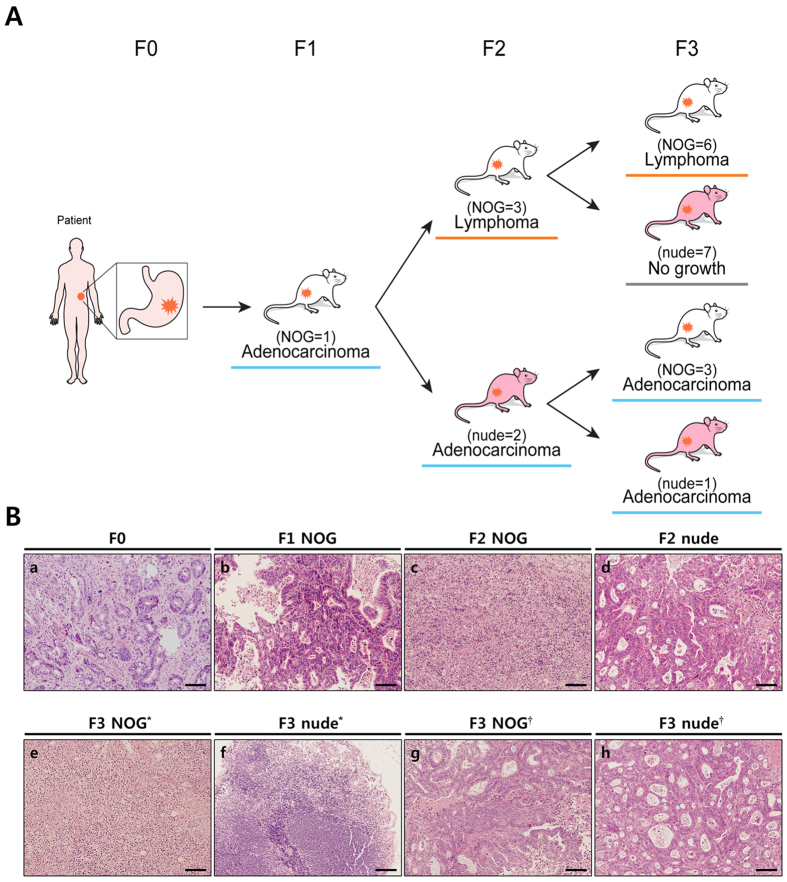
Schematic drawing of sequential histological changes into lymphomas according to the mouse strain during subpassaging in PDX model.(A) An engrafted adenocarcinoma in an F1 NOG mouse changed into a lymphoma in F2 NOG mice. It was retained in F3 NOG mice, but was not engrafted into F3 nude mice. However, an adenocarcinoma engrafted from an F1 NOG mouse into F2 nude mice retained their histology, and the tumour was not changed into a lymphoma in an F3 nude mouse as well as in F3 NOG mice. (B) Each section slide of primary and PDX tumour during subpassaging was stained by H & E for comparing their histological changes. a, adenocarcinoma in a primary tumour; b, adenocarcinoma in an F1 NOG mouse; c, lymphoma in an F2 NOG mouse; d, adenocarcinoma in an F2 nude mouse; e, lymphoma in an F3 NOG mouse; f, no tumour growth in an F3 nude mouse from an F2 NOG mouse; g, adenocarcinoma in an F3 NOG mouse from an F2 nude mouse; h, adenocarcinoma from an F3 nude mouse from an F2 nude mouse. Scale bars = 100 μm. *from F2 NOG mice, †from F2 nude mice.